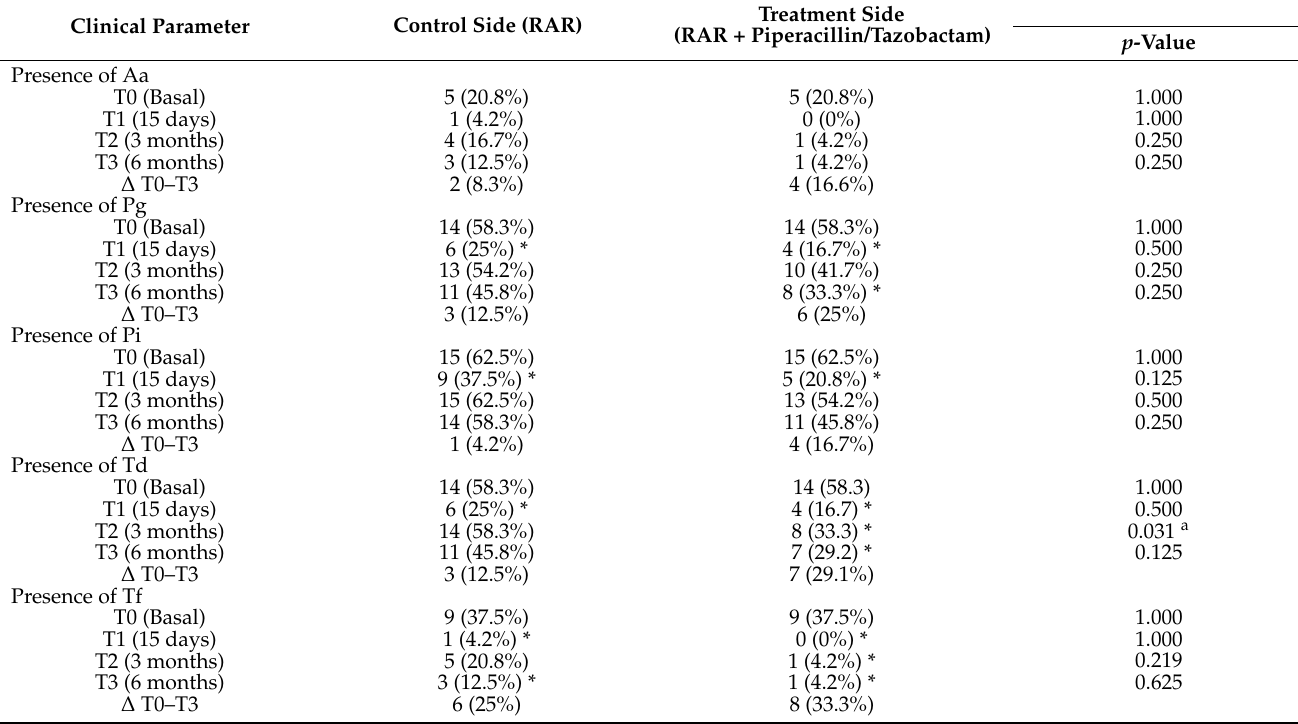
Table 3. Comparison of the presence of intergroup and intragroup bacteria in the different controls: T0 (Basal), T1 (15 days), T2 (3 months), and T3 (6 months) expressed in the number of patients and